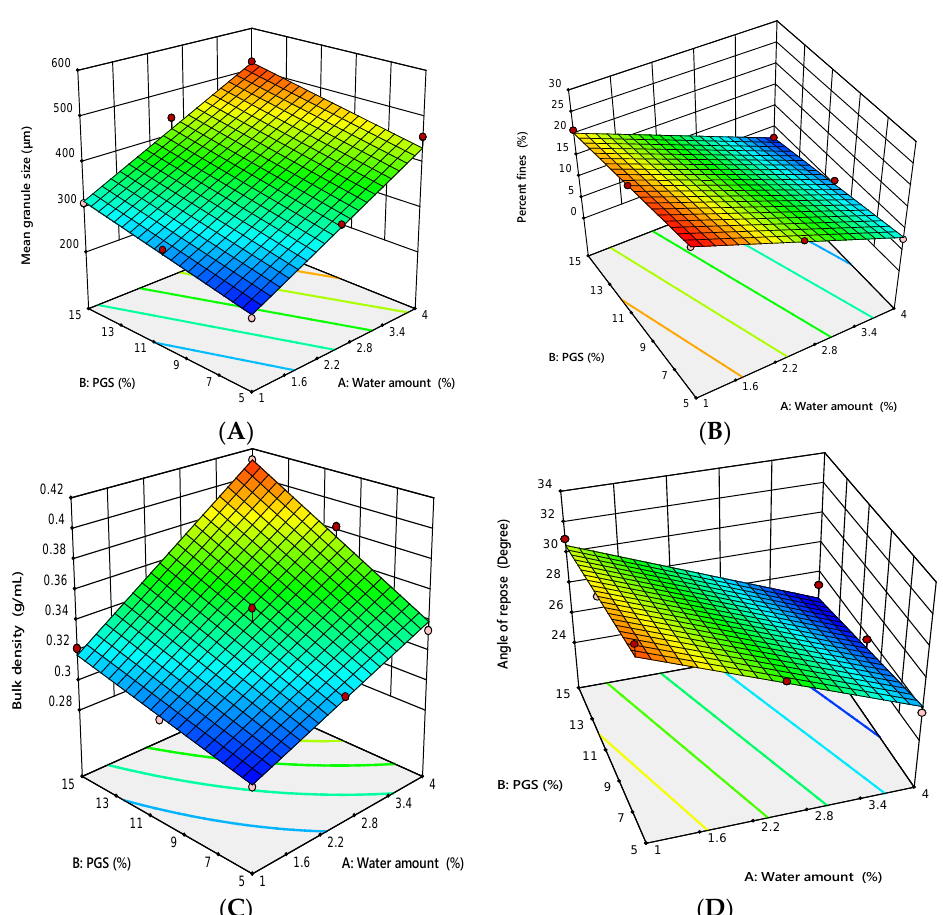
Figure 1. Response surface plot for the influence of the water amount (X 1 ) and pregelatinized starch (PGS) amount (X 2 ) on granules’ properties, ( A ) mean granule size ( B ), percent fines, ( C ) bulk density, and ( D ) angle of repose.